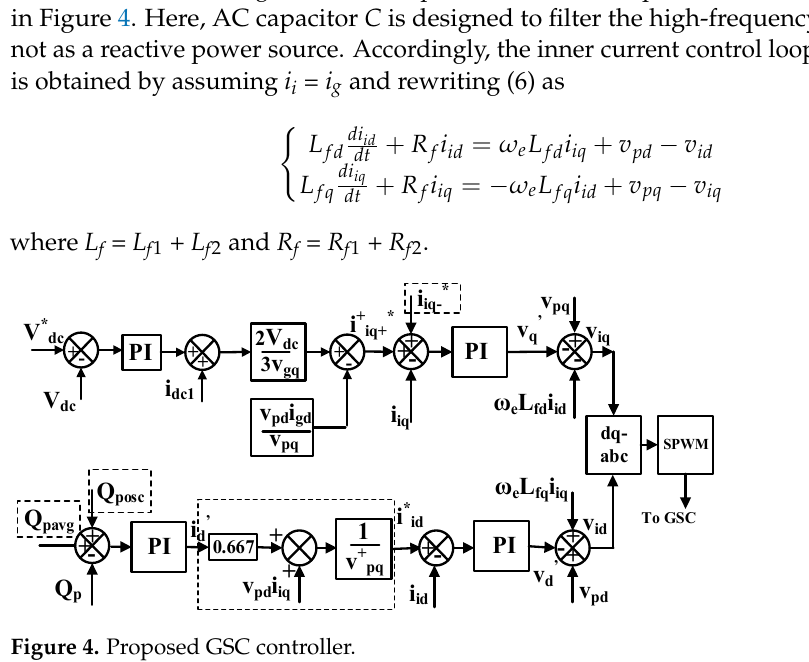
Figure 4. Proposed GSC controller.